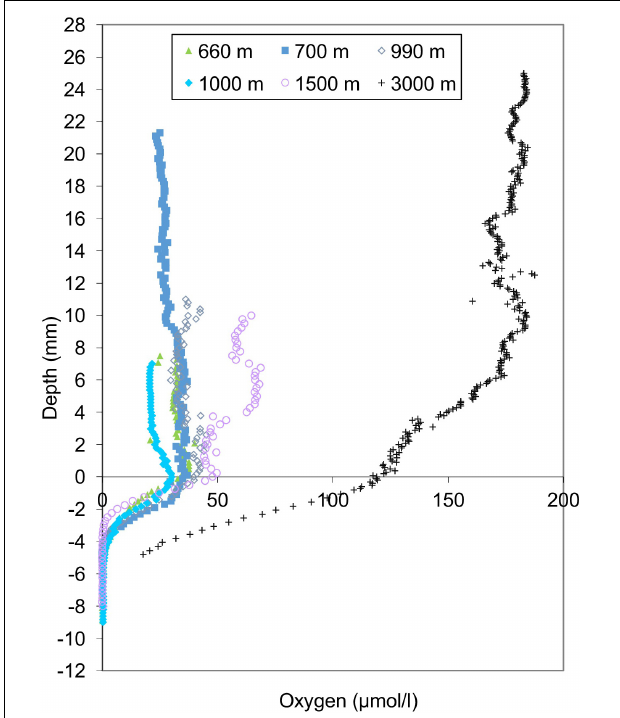
FIGURE 3 | Oxygen microprofiles for the six sites observed. Bottom water oxygen measurements from oxygen microprofiles were consistent with CTD casts. Oxygen microprofiles reveal that oxygenated pore waters were present in sediment depths up to 5